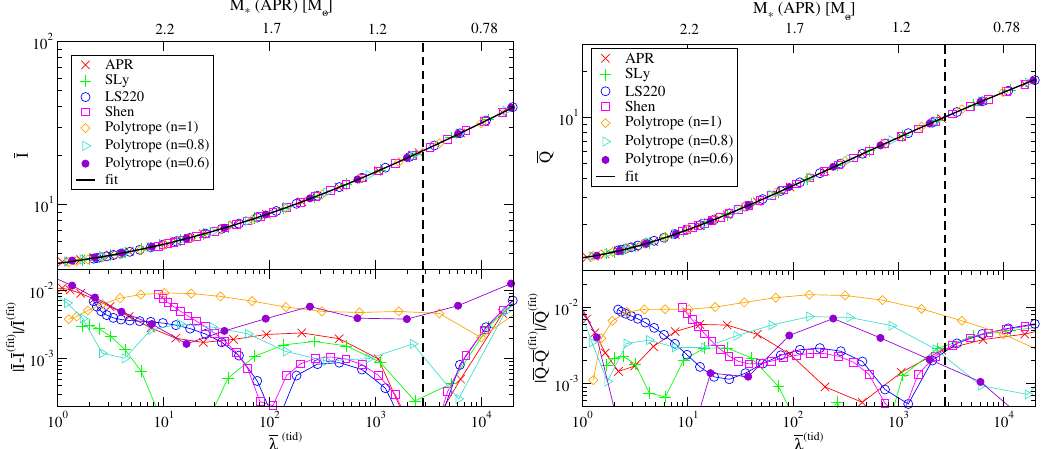
Figure 5: Top: Fitting curves (solid curve) and numerical results (points) of the universal I-Love (left) , ¯ 𝜆 (tid) = 𝜆 (tid) /𝑀 5 and Q-Love (right) relations for various equations of state, normalized as ¯ 𝐼 = 𝐼/𝑀 3 NS NS ) 2 ], 𝑀 NS is the neutron-star mass, 𝜆 (tid) is the tidal Love number, 𝑄 (rot) ( 𝑆/𝑀 2 and ¯ 𝑄 = − 𝑄 (rot) / [ 𝑀 3 NS NS is the rotation-induced quadrupole moment, and 𝑆 is the magnitude of the neutron-star spin angular momentum. The neutron-star central density is the parameter varied along each curve, or equivalently the neutron-star compactness. The top axis shows the neutron star mass for the APR equation of state, with the vertical dashed line showing 𝑀 NS = 1 𝑀 ⊙ . Bottom: Relative fractional errors between the fitting curve and the numerical results. Observe that these relations are essentially independent of the equation of state, with loss of universality at the 1% level. Image reproduced by permission from [452], copyright by